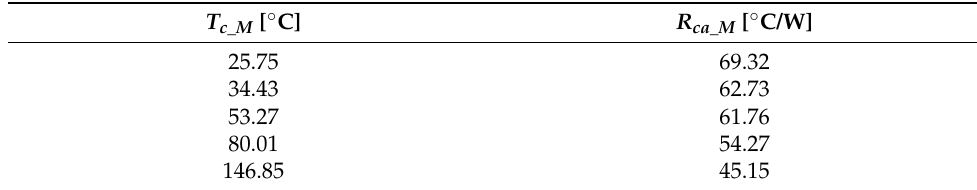
Table 2. R ca for the MOSFET.